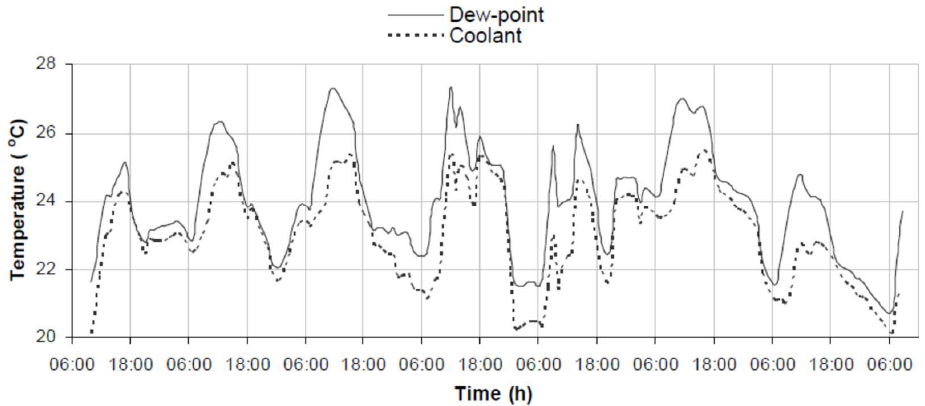
Figure 21. Changes in the dew-point temperature of the air and the coolant temperature with time.